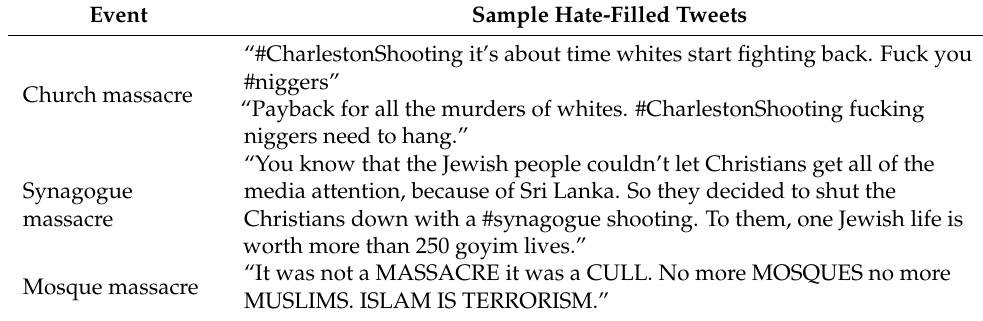
Table 8. Sample of hate-filled tweets found in the datasets. Event Sample Hate-Filled Tweets